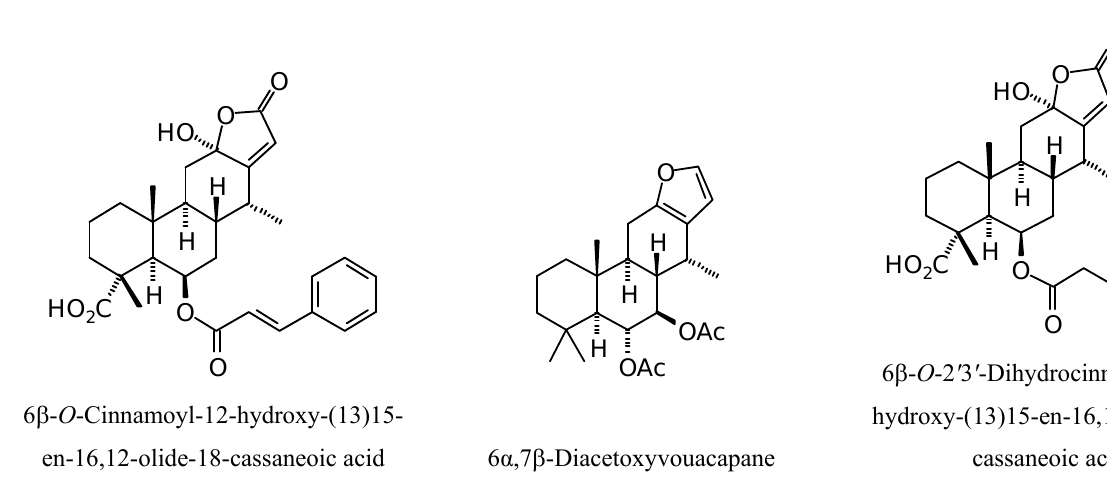
Figure 15. Cassane diterpenoids examined in this study.